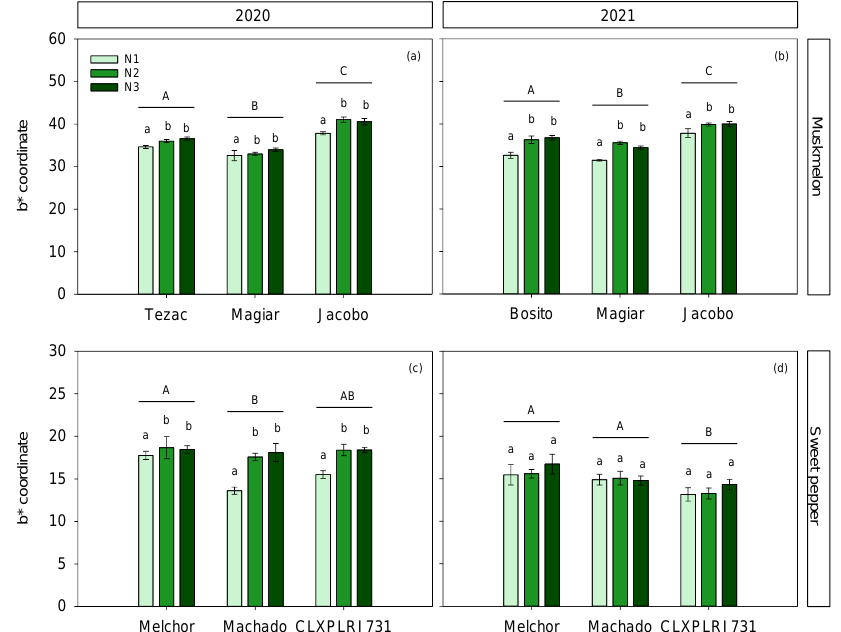
Figure 7. Fruit b* (blue–yellow axis) for three cultivars and three N treatments, for muskmelon ( a , b ) and sweet pepper ( c , d ) crops, conducted in 2020 and 2021 years. Fruit measurements are internal for muskmelon and external for sweet pepper. Different lowercase letters show significant differences between N treatments within each cultivar; different uppercase letters show significant differences between cultivars. Values are means ± SE.